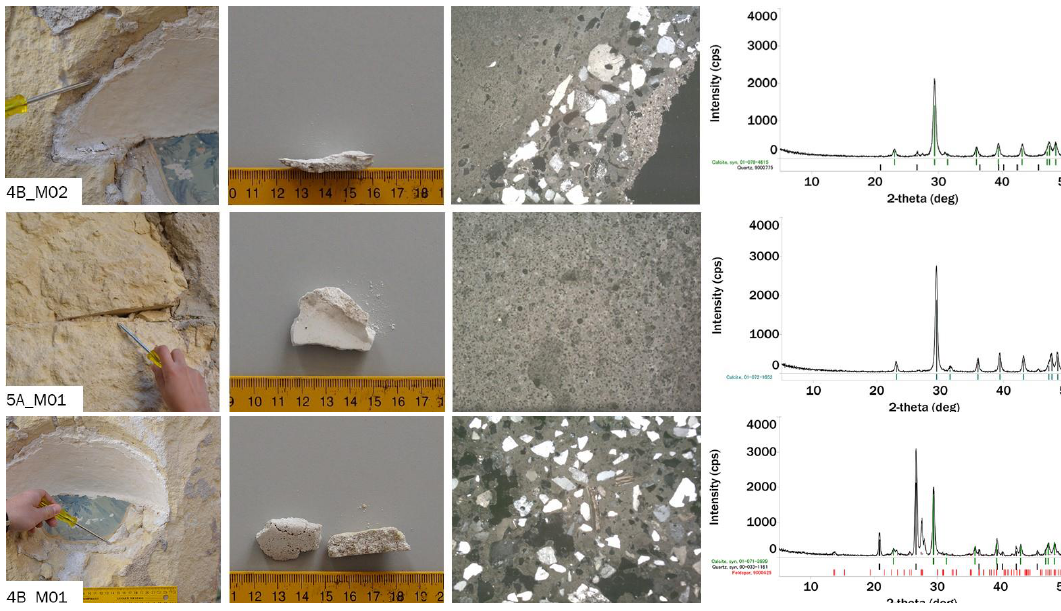
Figure 6. Minero-petrographic analysis. From the left: a) localisation of the sample; b) macro photo; thin sections under the optical microscope in Transmitted Light and X-Ray diffraction analysis (Laboratory analysis: Grillo S.M., LabMaST. Graphic elab: Pilia E.).